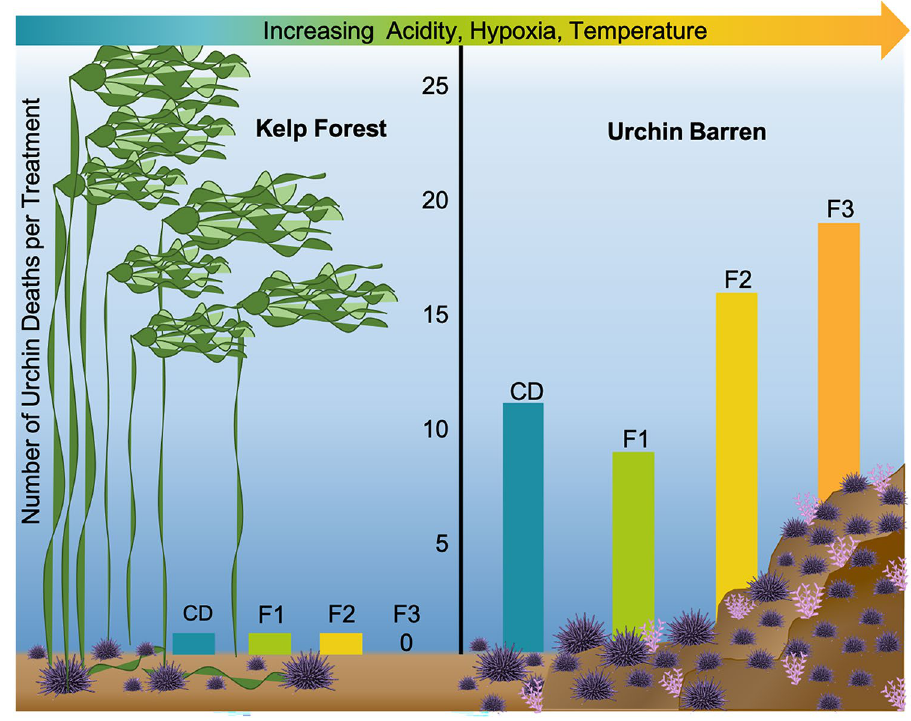
Figure 3. Total number of deaths for kelp forest and urchin barrens urchins in each of the four upwelling severity treatments. KEY: CD - Current Day, F1 - Future 1, F2 - Future 2, F3 - Future